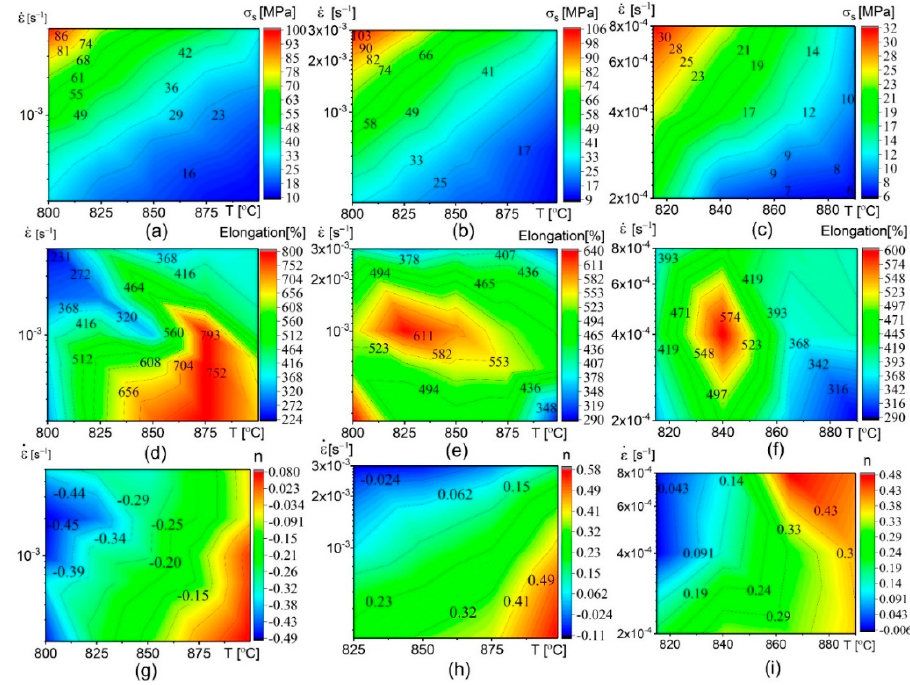
Figure 4. Dependence of the σ s ( a – c ); elongation to failure ( d – f ); and strain hardening/softening coefficient ( g – i ) on temperature and strain rate for the tested alloys: Ti-3%Mo-1%V-4%Al alloy ( a , d , g ); Ti-4%V-6%Al alloy ( b , e , h ); and Ti-1.8%Mn-2.5%Al alloy ( c , f , i ).